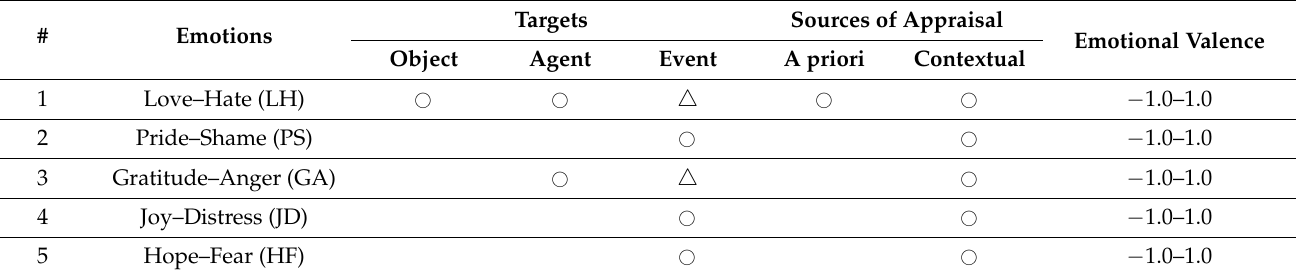
Table 3. The contextual emotion appraisal model with targets and source of emotions where circles mean direct relationship, triangles as indirective relationship, and vacant blocks as